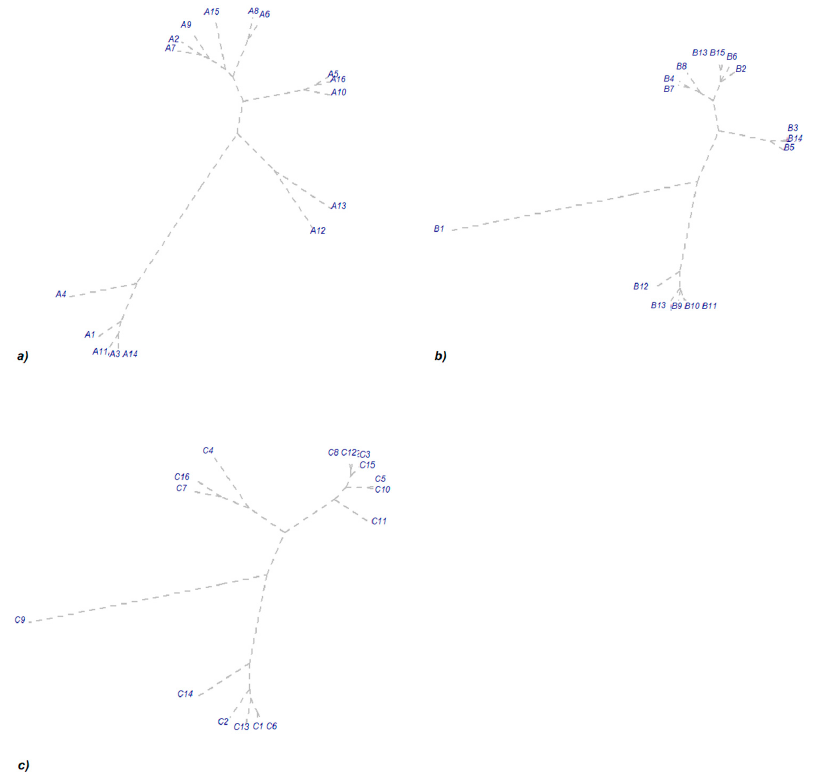
Figure 1. Cluster analysis of single-year arbuscular mycorrhiza profile winter wheat due to applied fertilizers: ( a ) 2014–2015 (A); ( b ) 2015–2016 (B); ( c ) 2016–2017 (C). Each point comprises the recorded values of frequency, intensity, arbuscularity, and colonization degree for a specific treatment.